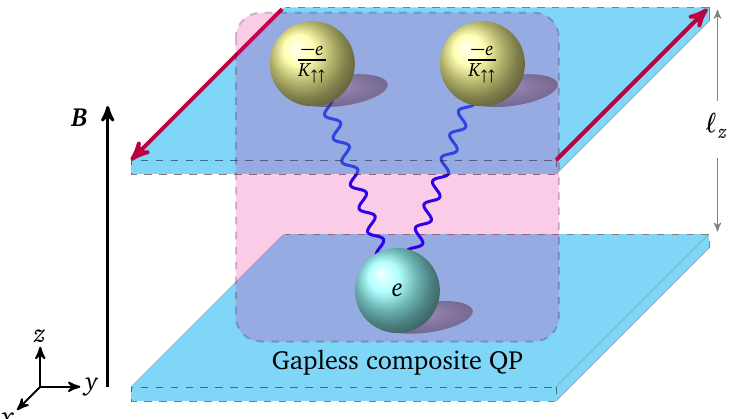
Figure 1: A semi-quantized quantum Hall state in a quantum Hall bilayer. The top layer is similar to a Laughlin state at filling factor 1 / K ↑↑ , featuring a bulk gap and gapless edge states (indicated by red arrows). Gapless quasiparticles (QP) are com- posed of an electron in the bottom layer glued to Laughlin-like quasi-holes in the top layer by strong interlayer interactions. B is the magnetic field, (cid:96)